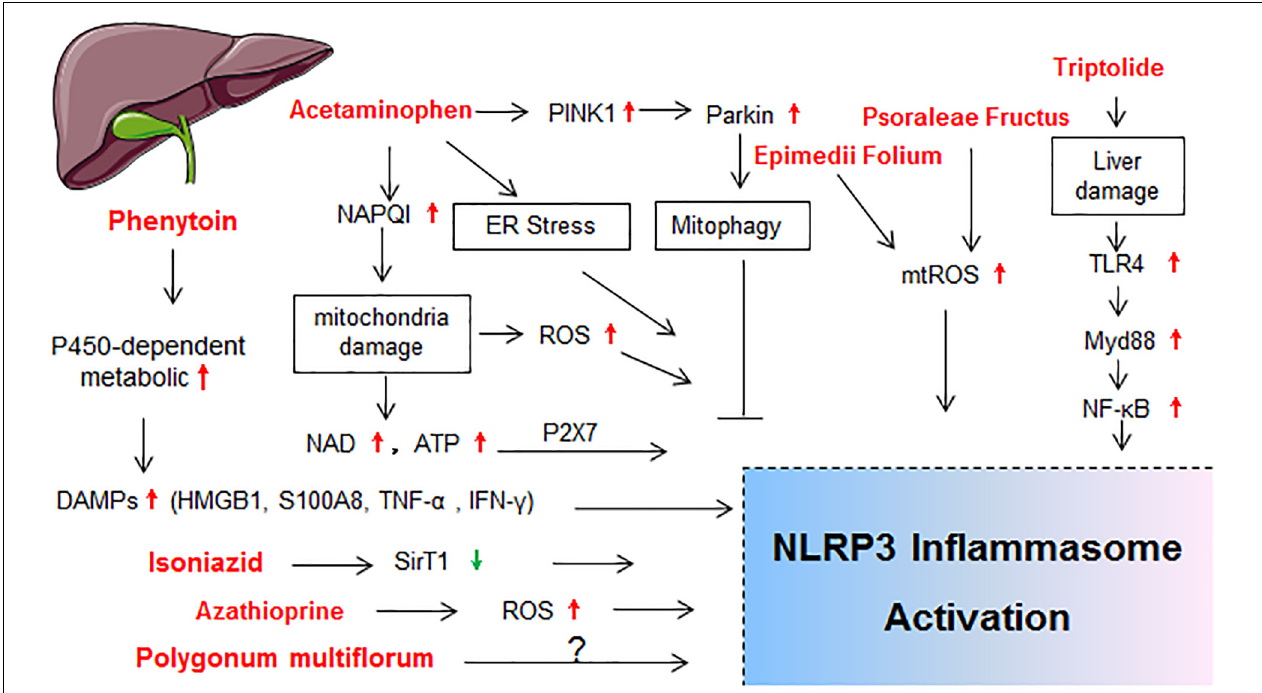
FIGURE 2 | Schematic diagram showing the molecular mechanisms of NLRP3 activation in drug-induced liver injury. BMDMs, bone marrow derived macrophages; ER stress, endoplasmic reticulum stress; HMGB1, high mobility group protein; IL-1R1, IL-1 receptor type 1; LSECs, liver sinusoidal endothelial cells; NAD; nicotinamide adenine dinucleotide; NLRP3 inflammasome, including NLRP3, ASC and caspase-1; TLR4, toll-like receptor 4; TNF- α , tumor necrosis factor-alpha; TXNIP; thioredoxin-interacting protein.